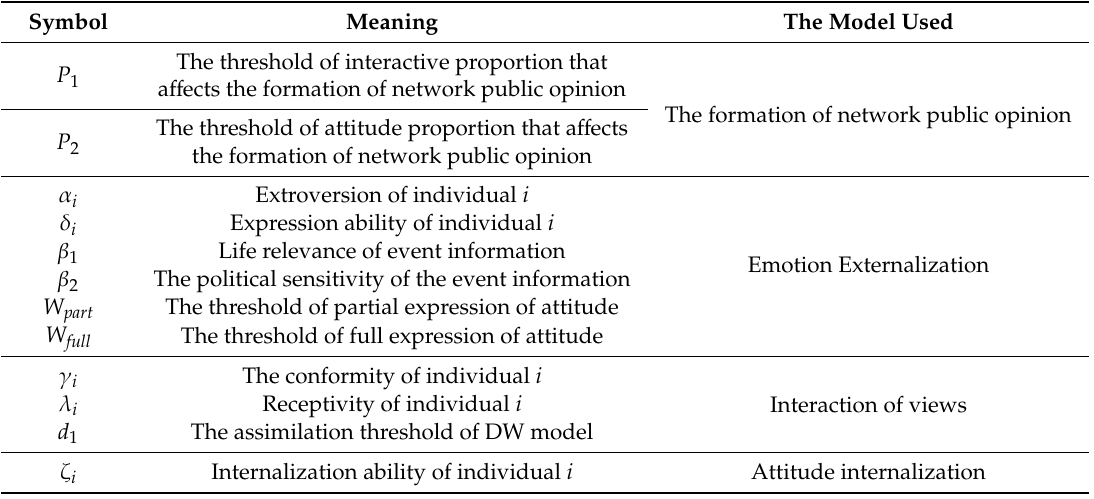
Figure 2. Model diagram. Table 1. Parameters involved in the model.